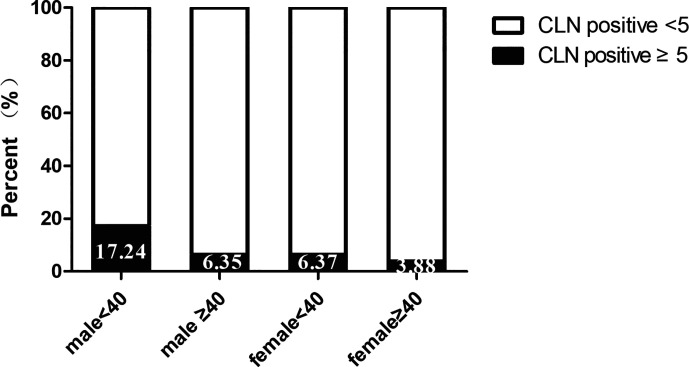
Central lymph node metastasis volume according to sex and age.